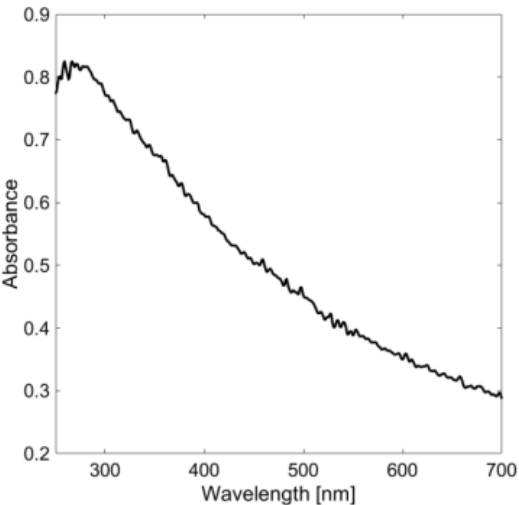
Figure 3. Typical UV-vis absorbance spectrum of the studied samples.